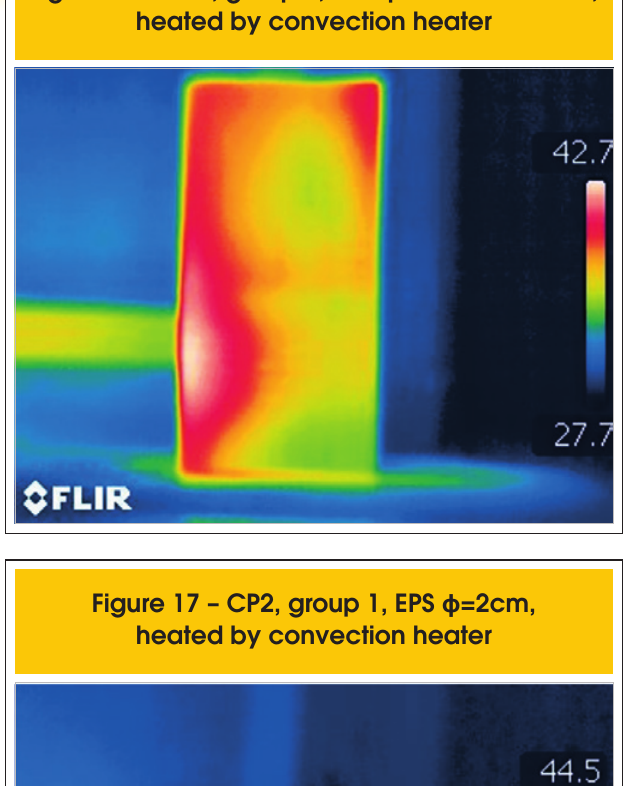
Figure 17 – CP2, group 1, EPS ϕ =2cm, heated by convection heater